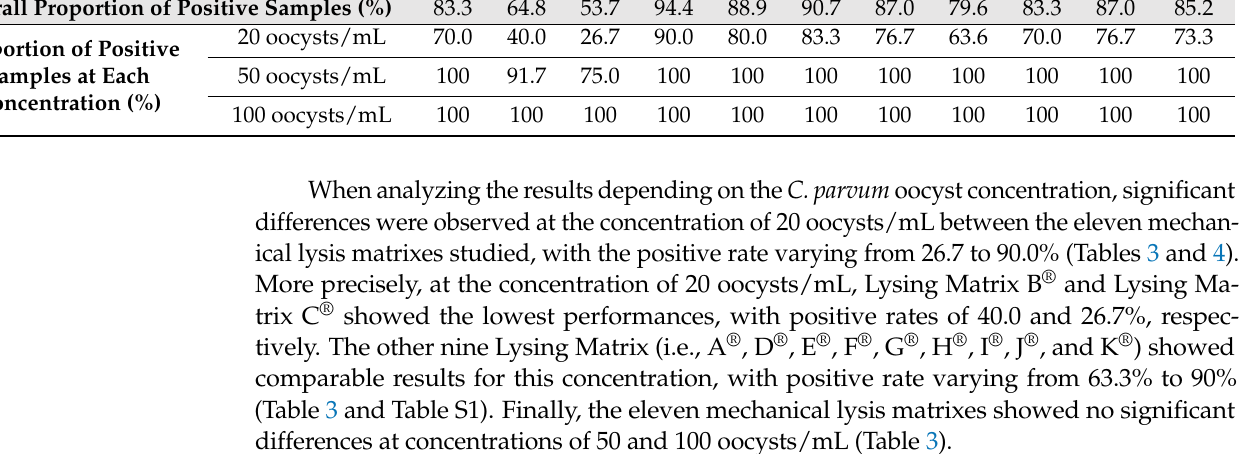
Table 3. Performances of the eleven mechanical lysis matrixes studied for Cryptosporidium parvum DNA extraction and amplification. Lysing Matrix ® Overall Proportion of Positive Samples (%)